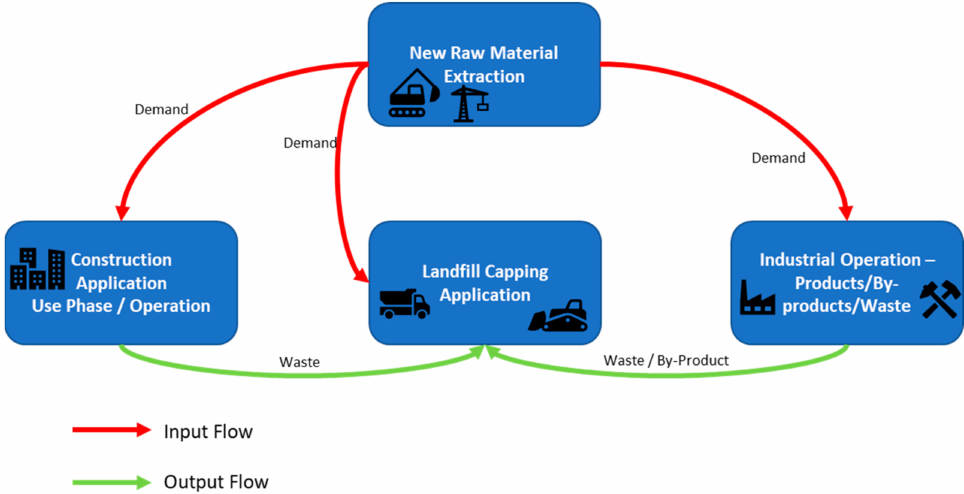
Figure 11. Schematic material demand for landfill sealing applications in